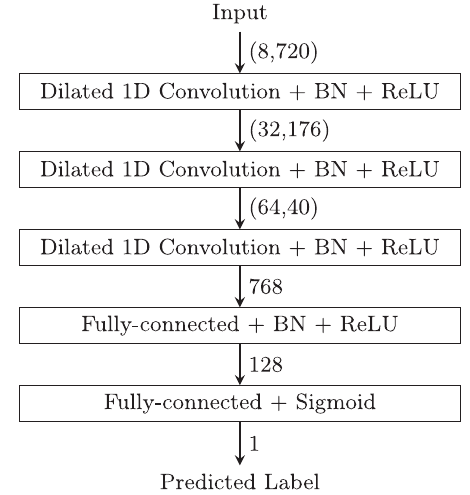
(2021).FIG. 8. The model architecture of the demonstration DNN, showing the input size to each layer.